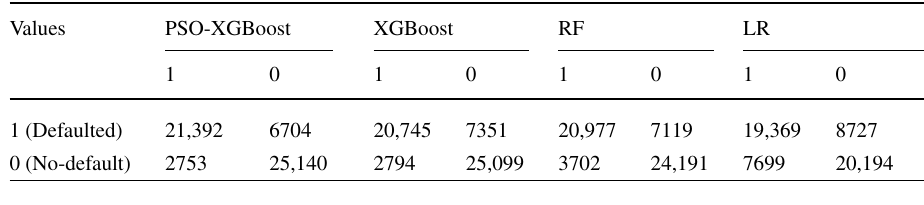
Table 12 Comparison of evaluation indexes of models Evaluation index